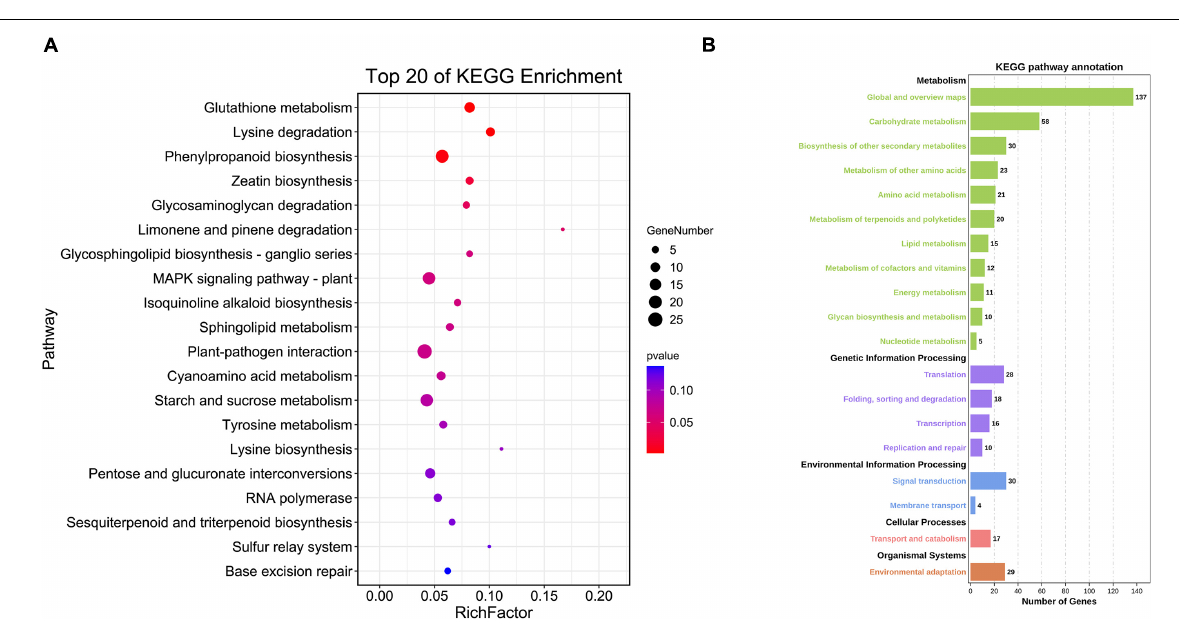
FIGURE 8 | KEGG enrichment analysis of BnGWRKY potential target genes in Boehmeria nivea . (A) Top20 of KEGG enrichment. (B) KEGG pathway